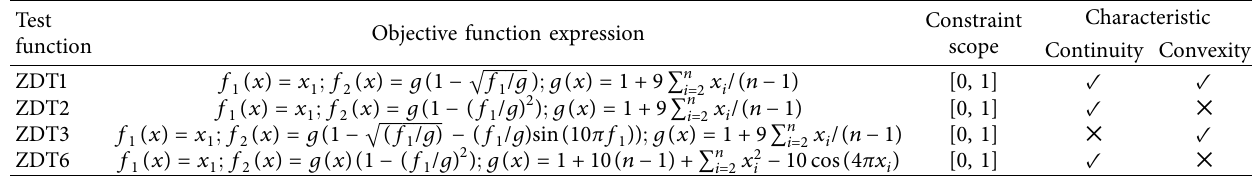
Table 12: Four test functions details of multiobjective optimization